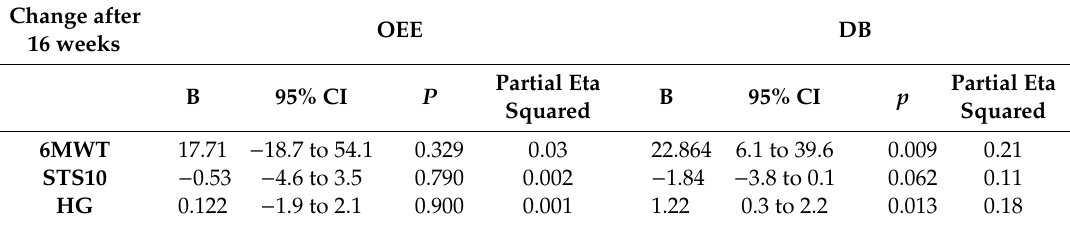
Table 6. Association between baseline OEE / DB score and physical improvement after 16 weeks. Change